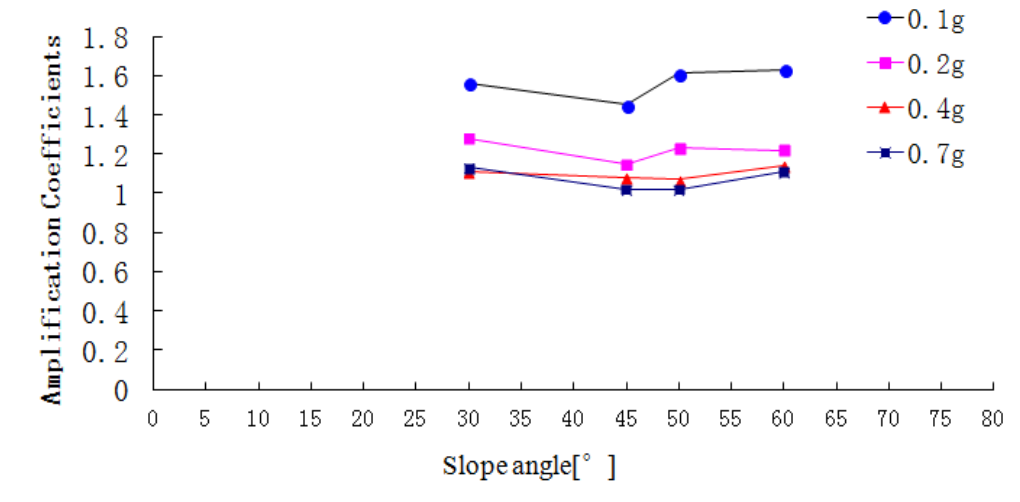
Figure 19. The peak acceleration amplification coefficient in the slope direction.